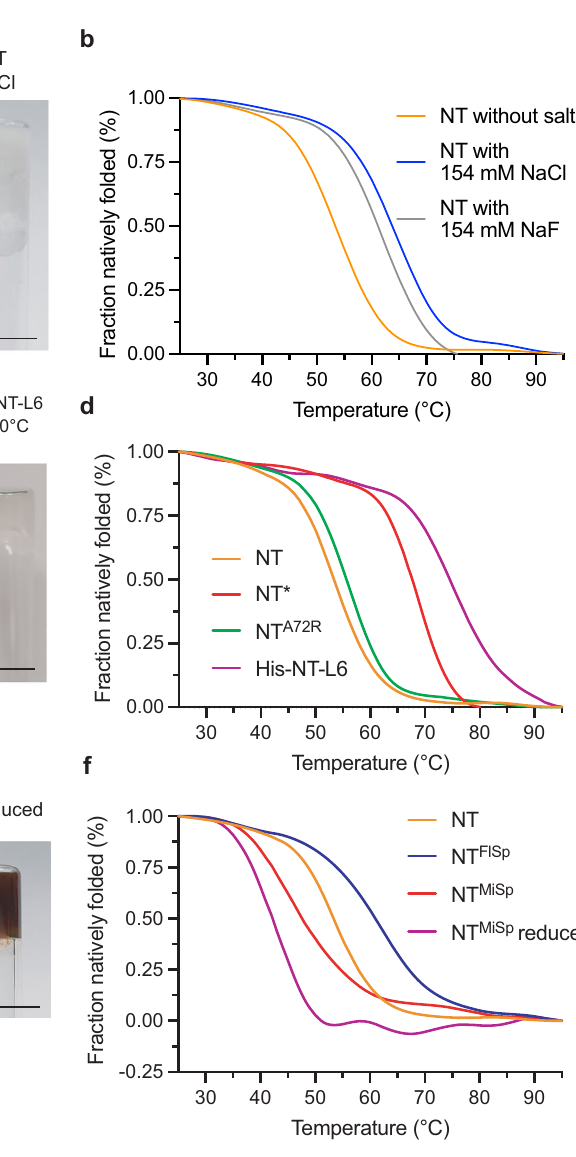
Fig. 5 | Hydrogel formation of different NTs and their thermal stability. a Vial inversion tests of NT (100mg/ml) at pH 8, 7, 6 and with 154mM NaCl (pH 8) after incubation at 37°C. b CD spectroscopy of NT with and without 154mM NaF and 154mM NaCl, respectively. Molar ellipticity at 222nm converted to fraction natively folded. c Vial inversion test of NT mutants (100mg/ml) NT* (37°C and 60 °C) NT A72R (37°C) and His-NT-L6 (37°C and 60 °C). d CD